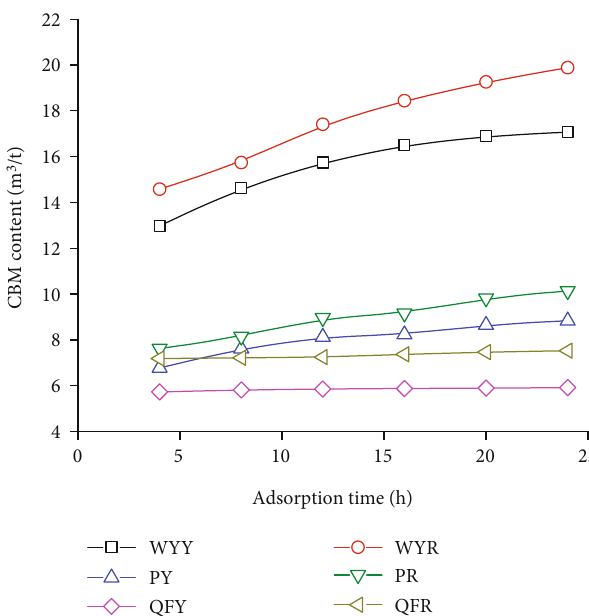
Figure 9: CBM content of di ff erent coal